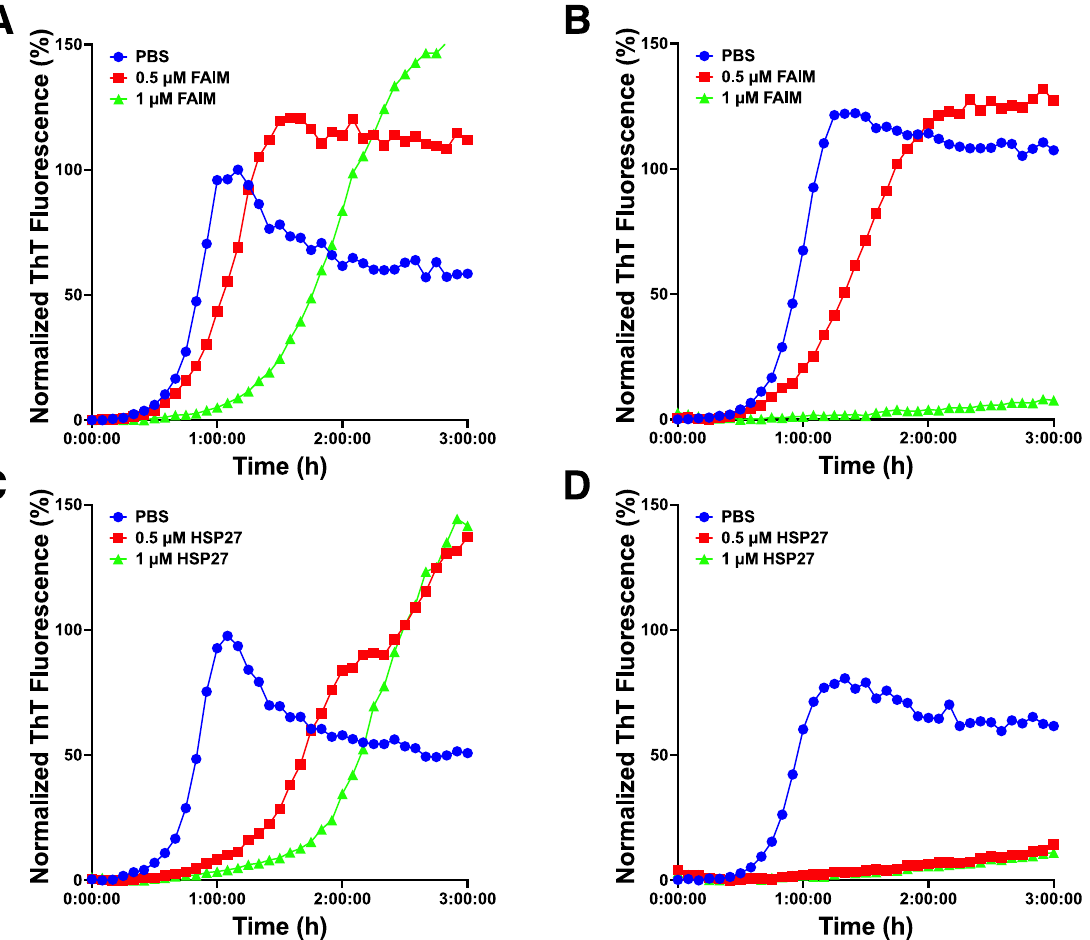
Figure 5. Recombinant FAIM-S protein suppresses amyloid- β fibrillization/aggregation in conjunc- tion with HSP27 in a cell-free system. Spontaneous fibrillization of amyloid- β (5 μ M) in vitro was monitored by ThT assay over a period of 3 h with the indicated concentration of recombinant FAIM-S in the absence ( A ) or presence ( B ) of 0.25 μ M HSP27. ThT assay was also carried out with different concentrations of HSP27 in the absence ( C ) or presence ( D ) of 0.25 μ M FAIM-S. ThT fluorescence was recorded every 5 min. Background ThT fluorescence is subtracted from sample readings at each time point, and is normalized to 100% of the maximum value in the PBS control. Representative data from 3 independent experiments are shown.